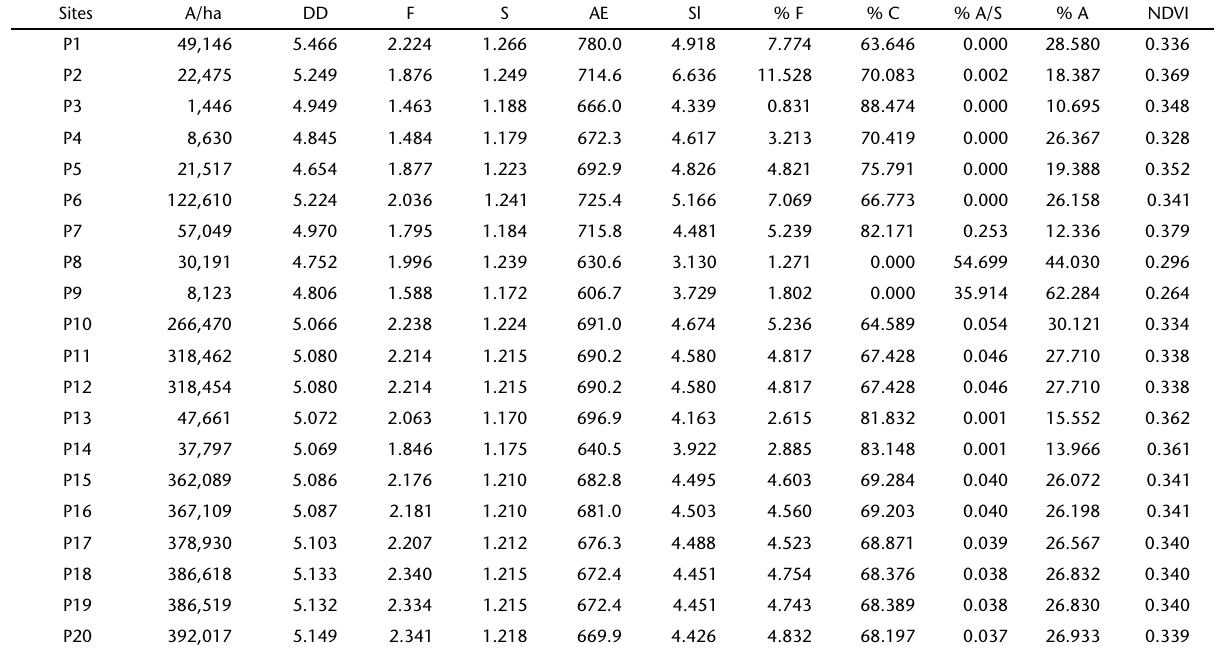
Table I. Average values for non-forest areas (A/ha), drainage density (DD), drainage form (F), sinuosity (S), average elevation (AE), slope (Sl), percentage of forest (% F), cerrado (% C), agriculture/silviculture (% A/F), anthropic areas (% A), and NDVI at each of the sampling sites along the Pandeiros River